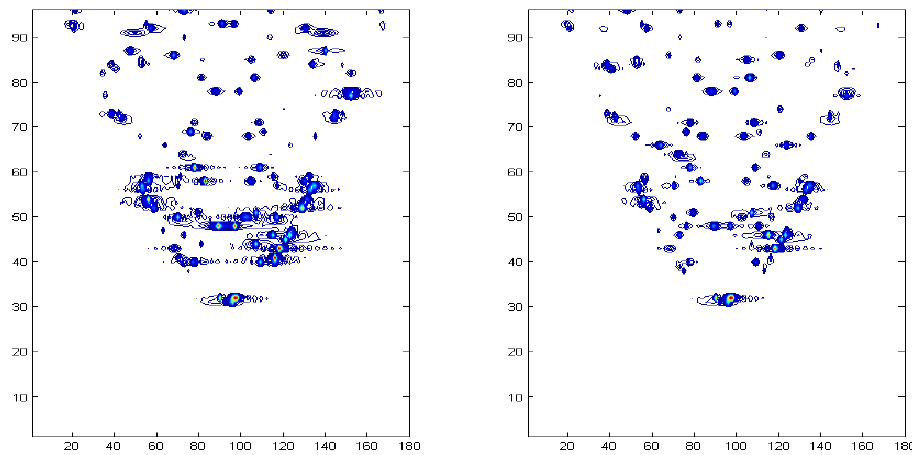
Fig. 7. Comparative radar images for two-channel radar with pulse radiation.